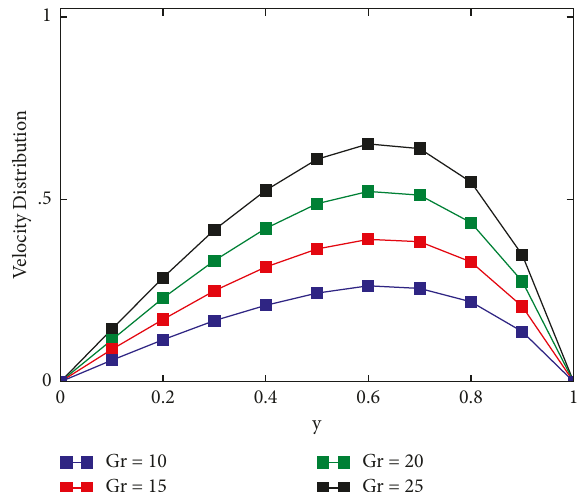
Figure 16: The influence of Gron velocity when β